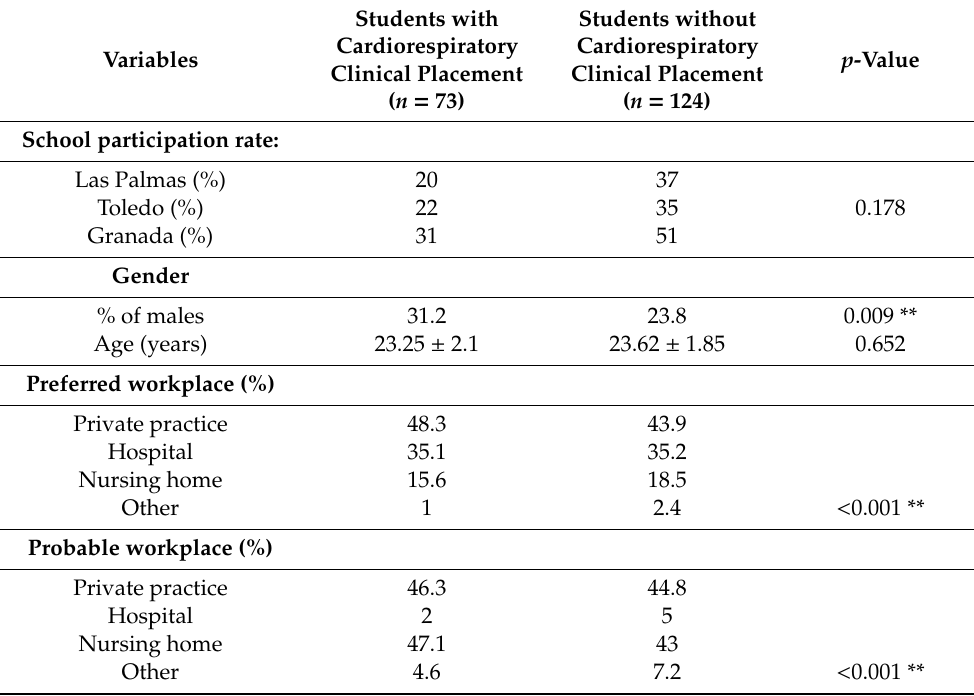
Table 1. Sample description according to cardiorespiratory-related clinical placement.